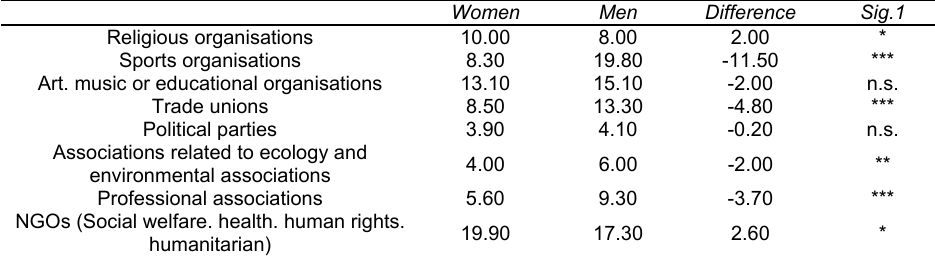
Table 7. Membership percentage of voluntary organisations according to gender